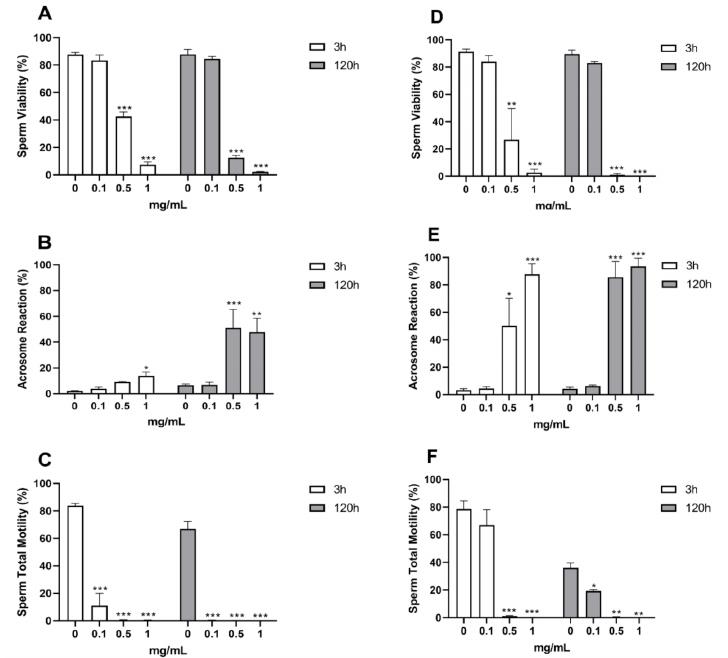
Figure 2. Effects of Cz ( A – C ) and Ov ( D – F ) EOs on sperm viability ( A , D ), acrosome reaction ( B , E ) and sperm motility ( C , F ). Data are expressed as mean ± standard error of the mean. 0 = control samples (only emulsifiers). * p < 0.05; ** p < 0.01; *** p <